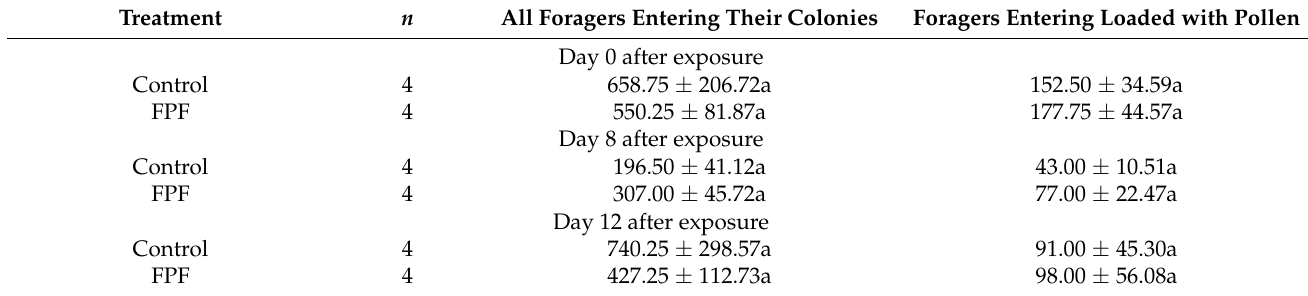
Table 2. Mean number of foragers entering their colonies and foragers entering their colonies loaded with pollen of A. mellifera . Numbers are mean ± SE (standard error). Forgers entering their hives and foragers returned loaded with pollen grains at 7–9 am at days 0, 8, and 12 after FPF exposure. Same letters following the data in the same column mean no significant differences ( p > 0.05).